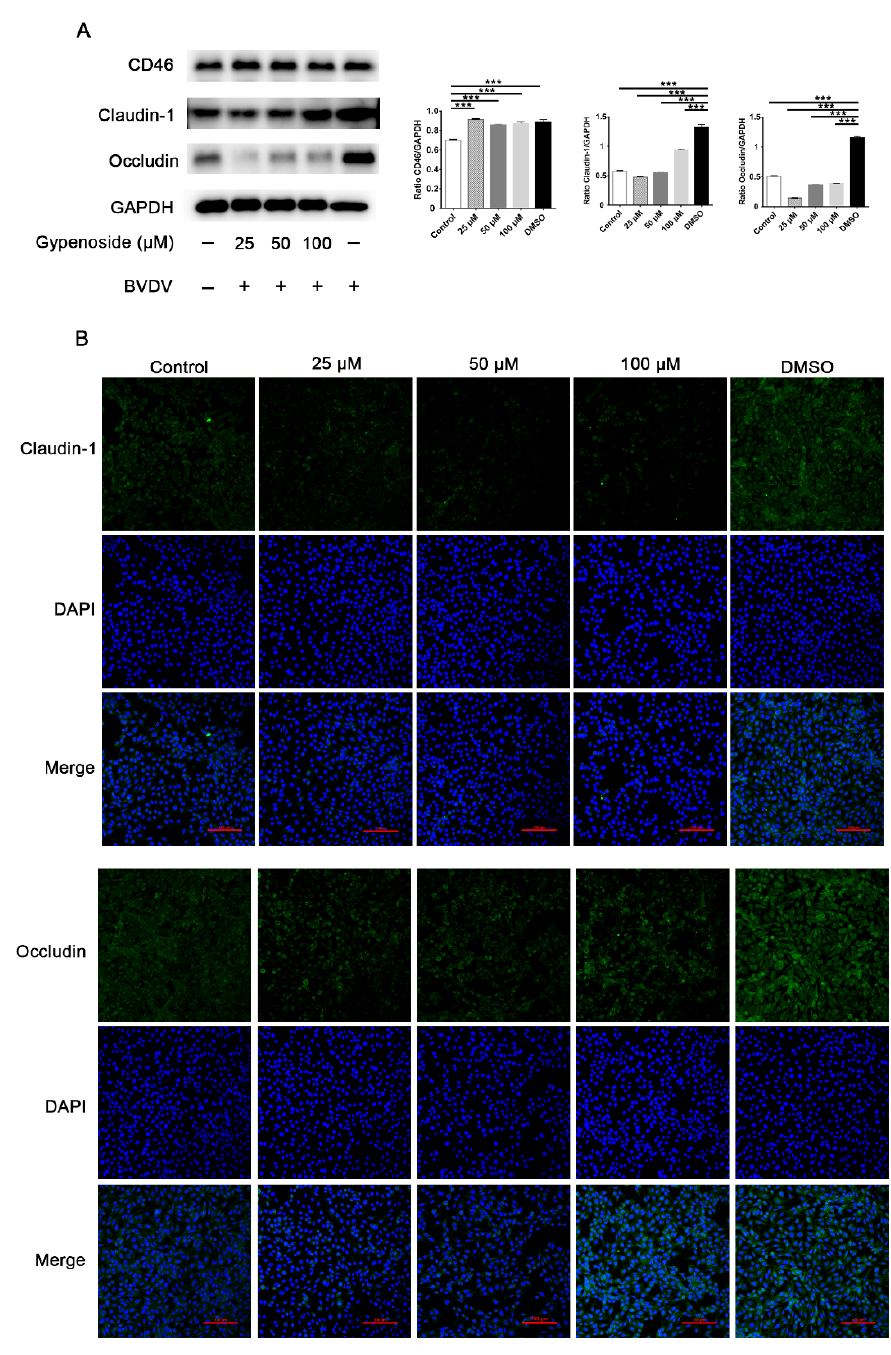
Figure 4. Gypenoside downregulated tight junction protein expression in BVDV-infected cells. ( A ) Representative panels showing the expression of claudin-1, occludin, CD46, and GAPDH in BVDV-infected cells treated with the indicated concentrations of gypenoside. The results are presented as the ratio of the protein band intensities of claudin 1, occludin, and CD46 to the intensity of the GAPDH band. ( B ) IFA staining for assessing the effects of the treatment with the indicated concentrations of gypenoside on claudin-1 and occludin in BVDV-infected cells. Claudin 1 or occludin (green) and DAPI (blue). Data are presented as the mean ± SEM of three independent experiments.*** p < 0.001. 3.4. Gypenoside Promotes BVDV-Inhibited Apoptosis in MDBK Cells BVDV-infected cells increased Bcl-2 and decreased cleaved caspase-3 protein expres- sion compared with uninfected cells, as shown by the negative TUNEL staining, indicat- ing that apoptosis was inhibited in BVDV-infected cells. Gypenoside treatment reduced